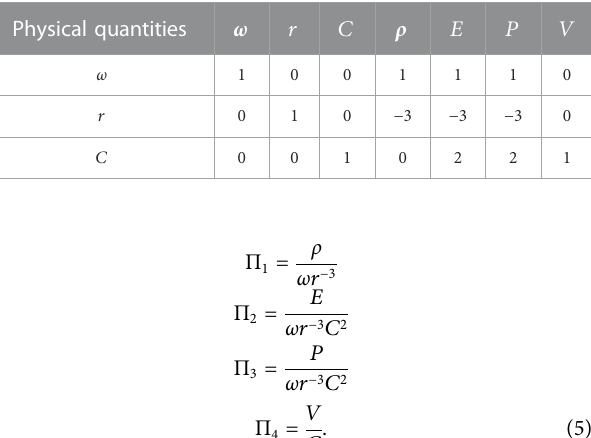
TABLE 6 Each physical quantity dimension power index (after